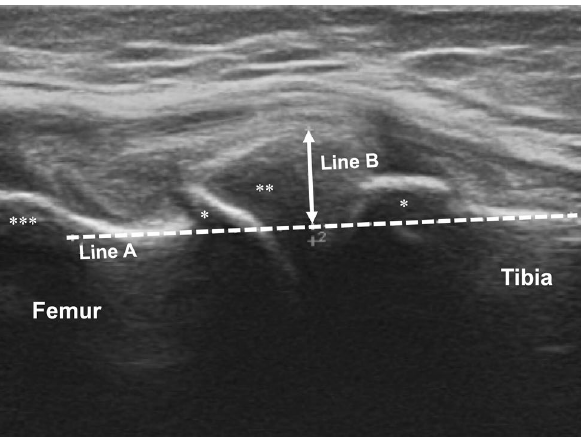
Figure 1. Ultrasonographic evaluation of medial meniscus extrusion. *Osteophyte, **Medial meniscus, ***Medial femoral epicondyle. Line A was drawn to connect the cortex of both the femur and tibia, thereby tracing the femoral cortex at the bottom of the medial femoral epicondyle. Line B was drawn perpendicularly from the bottom of Line A to the most medially extruded part of the medial meniscus. Line A was drawn through the osteophyte bases to avoid the bony interference of osteophytes throughout the length of Line B. Finally, the length of Line B (mm) was measured as the medial meniscus extrusion .